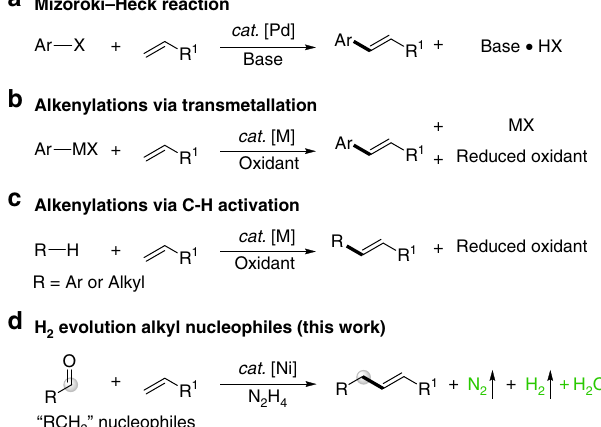
Fig. 1 Strategies in the Heck coupling reaction. a Traditional Mizoroki-Heck coupling with hazardous organic halide; b Oxidative Heck coupling with pre-synthesized organometallic reagent; c Stoichiometric oxidant mediated Heck coupling via C – H bond activation; d Oxidant-free direct dehydrogenative alkyl